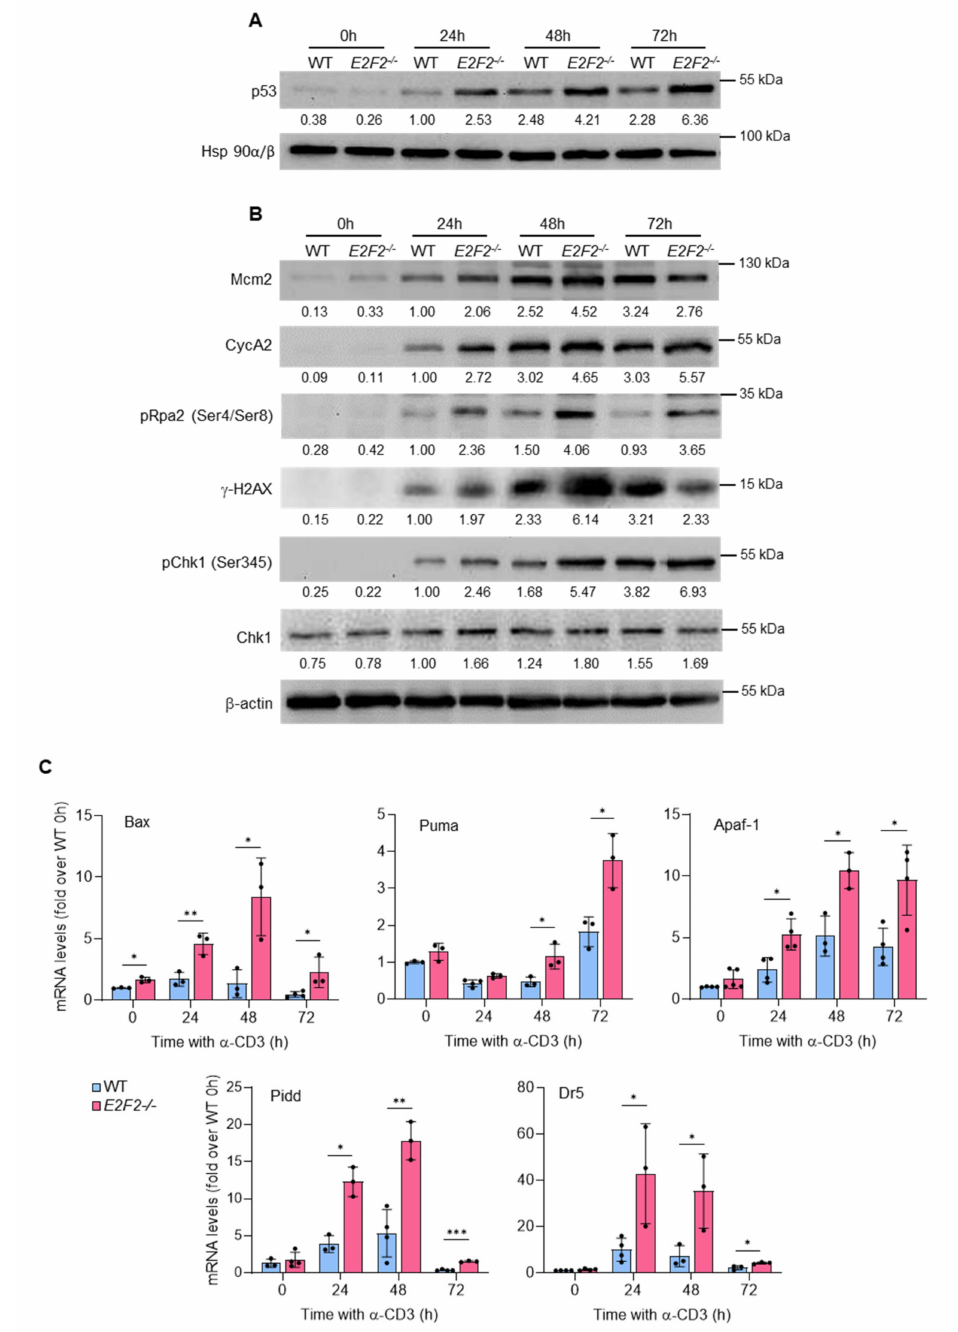
Figure 3. Apoptosis in TCR-stimulated E2f2 − / − lymphocytes is associated with accumulation of p53 and replication stress: ( A ) Representative Western blot analysis of p53 in extracts prepared from freshly purified WT and E2f2 − / − T cells at several times after stimulation with anti-CD3. Expression of Hsp90 α / β was used as loading control. ( B ) Representative Western blot analysis of several replication stress markers. Expression of β -actin was used as loading control. Numbers below the bands correspond to the relative densitometric values, expressed as fold-over WT at 24 h. Similar results were obtained in at least 4 independent experiments. ( C ) Reverse transcription qPCR analysis of p53-target genes in WT and E2f2 − / − T cells unstimulated or after stimulation with anti-CD3 during the indicated time. Eef1a1 was used as normalization control. Results are expressed as fold-over WT at 0 h (mean ± SD) from 3 to 5 independent experiments. *** p < 0.0001, ** p < 0.005, * p <